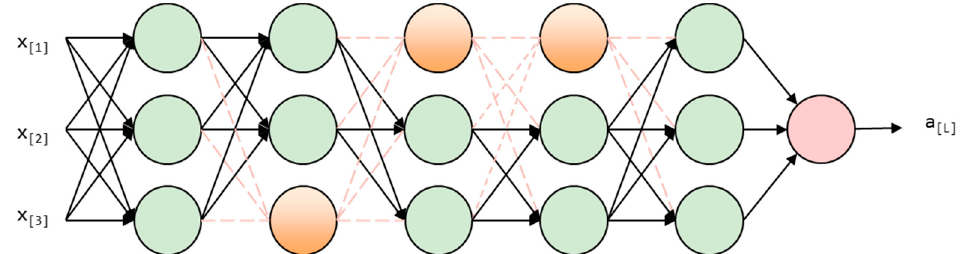
Figure 6. Dropout layer diagram.